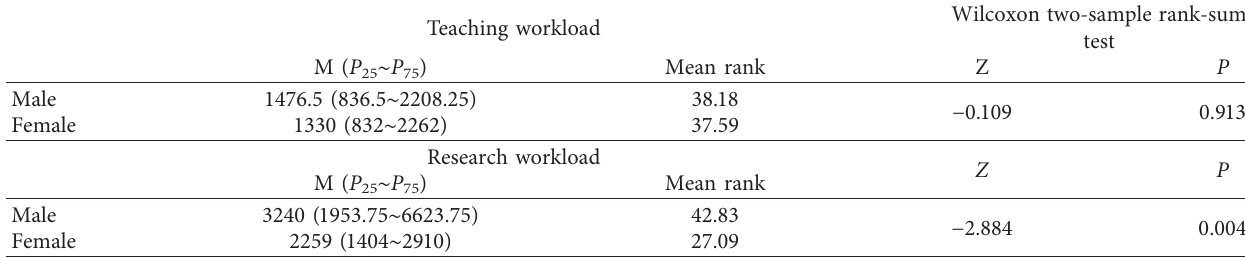
Table 5: Rank-sum test of teaching and research workload of teachers outstanding in research.